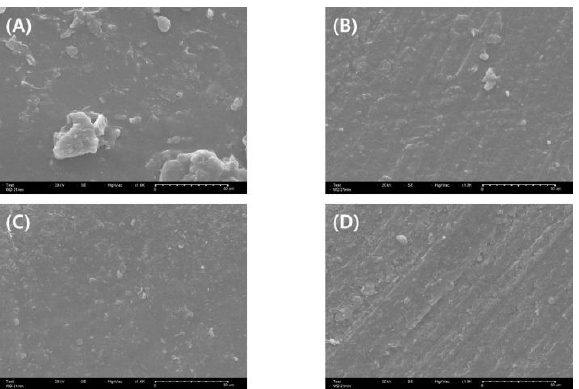
Figure 1. FE-SEM images at 1.0 K magnification after washing the surface of the specimen ( A ) IPA-D group: IPA dipping, ( B ) IPA-1 group: IPA washing for 1 min, ( C ) IPA-10 group: IPA washing for 10 min, ( D ) TPM-10 group: TPM washing for 10 min.